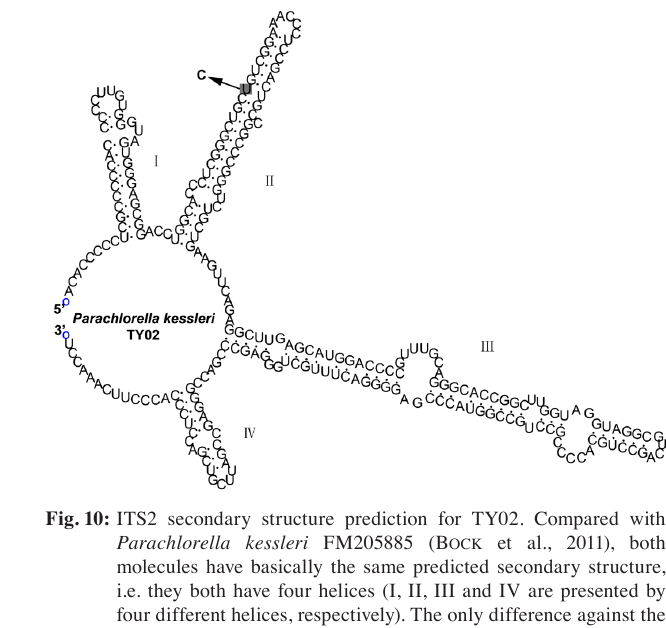
Fig. 10: ITS2 secondary structure prediction for TY02. Compared with Parachlorella kessleri FM205885 (B ock et al., 2011), both molecules have basically the same predicted secondary structure, i.e. they both have four helices (I, II, III and IV are presented by four different helices, respectively). The only difference against the closest sequenced relative P. kessleri FM205885 is high-lighted in gray. This position in TY02 is U, while in P. kessleri FM205885 it is C (position with the arrow point to).